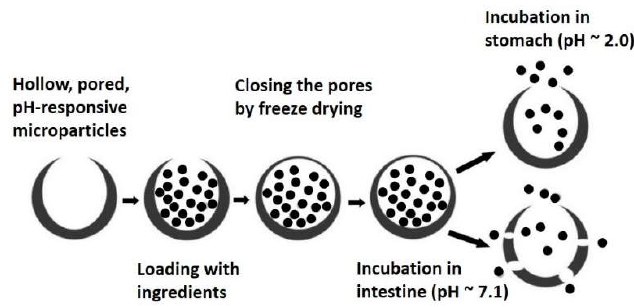
Figure 4. The schematic sequence of polymeric pored microencapsulation/release behavior.